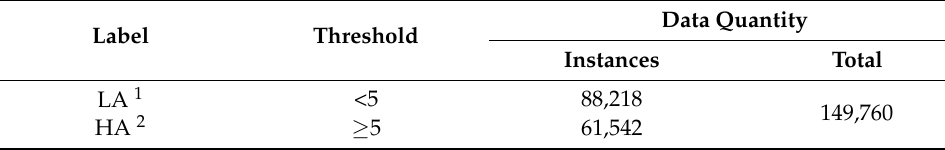
Table 2. Sample distribution on the arousal classification